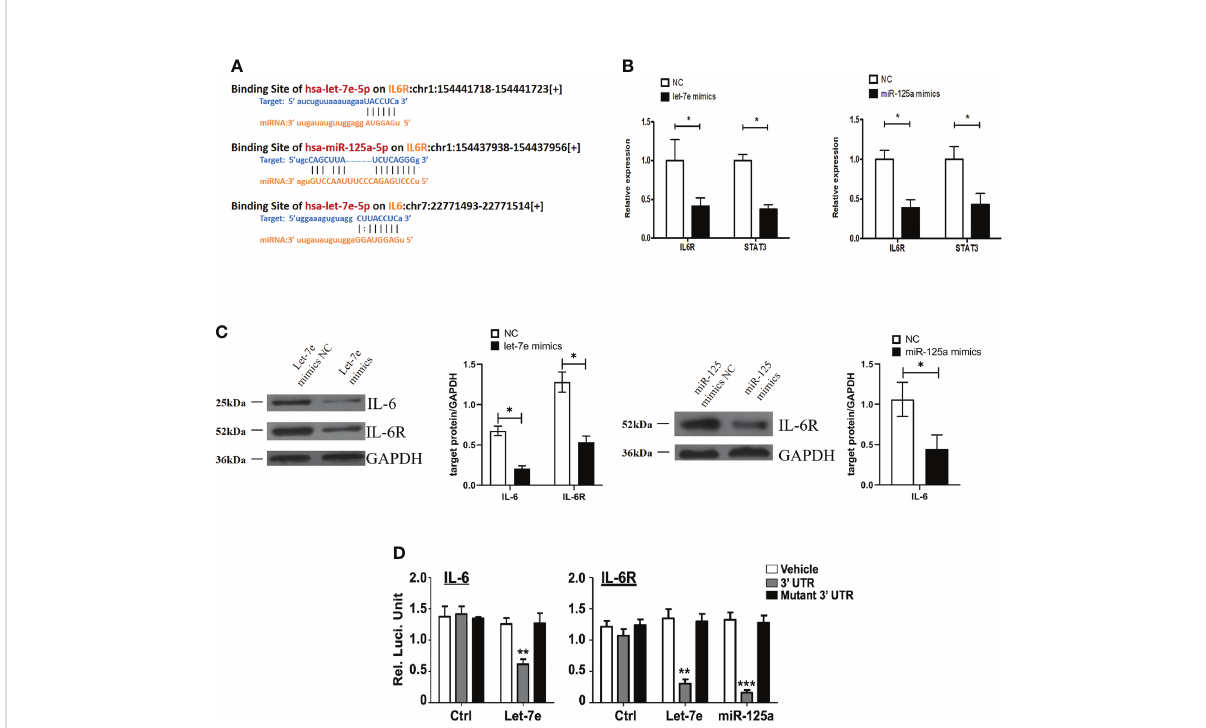
FIGURE 5 Let-7e inhibited the expression of IL-6 and IL-6R and miR-125a inhibited the expression of IL-6R. (A) Diagrams of binding side of let-7e and miR-125a matched the IL6 and IL6R gene. (B) Let-7e/miR-125a mimics are co-transfected into the U87 cells respectively, and then the expression of IL-6R is assessed by qRT-PCR analysis (n=3). GAPDH is used as a reference gene. (C) Western blot analysis of IL-6 and IL-6R proteins in U87 cells transfected with let-7e and miR-125a mimics (n=3). Quantitative results of western blot analysis are shown. (D) Let-7e and miR-125a mimics and reporter plasmids containing the wild type or mutant form of IL-6 3 ’ UTR and IL-6R 3 ’ UTR are co-transfected into the U87 cells, and then the luciferase activity is assessed after 48 h transfection. Expression of IL-6 and IL-6R are shown. Data are presented as the mean ± S.D. P value is determined by Student ’ s t test (*P < 0.05, **P < 0.01, ***P <